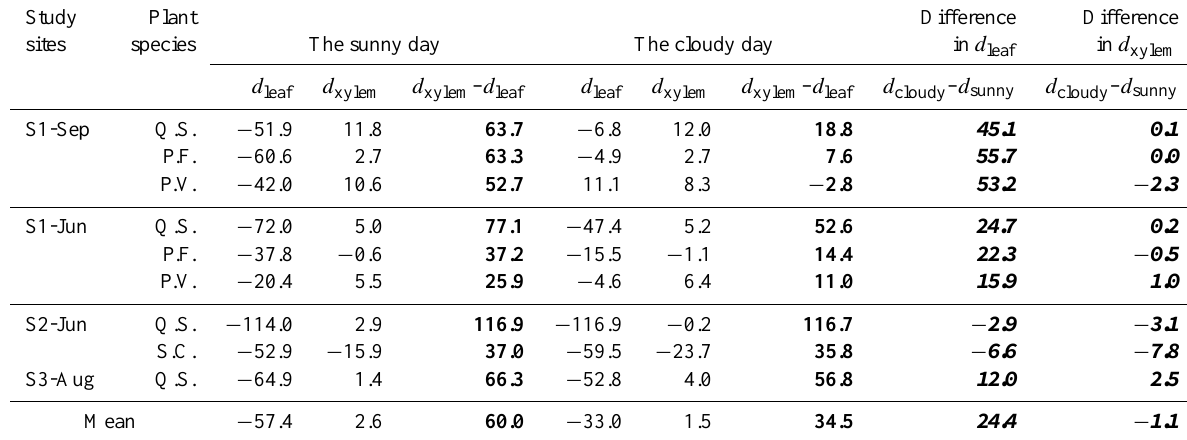
Table 5. Differences between d xylem (‰) and d leaf (‰) on the sunny and the cloudy days. The location ID and the abbreviations of plant Latin names are the same as in Tables 2 and